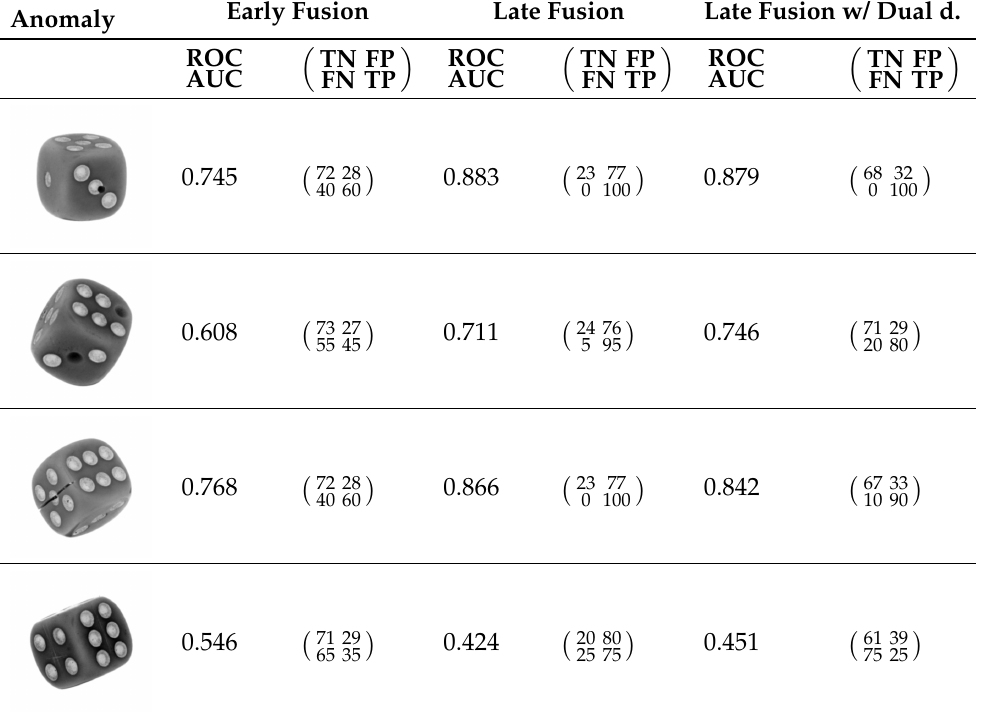
Table 8. ROC AUC scores and confusion matrices are given w.r.t. one particular type of anomaly. A denoising autoencoder and data augmentation are employed in the pre-training stage of Deep SVDD [6] for each of the fusion techniques. The confusion matrices are given in %. True positive samples (TP) are anomalous,